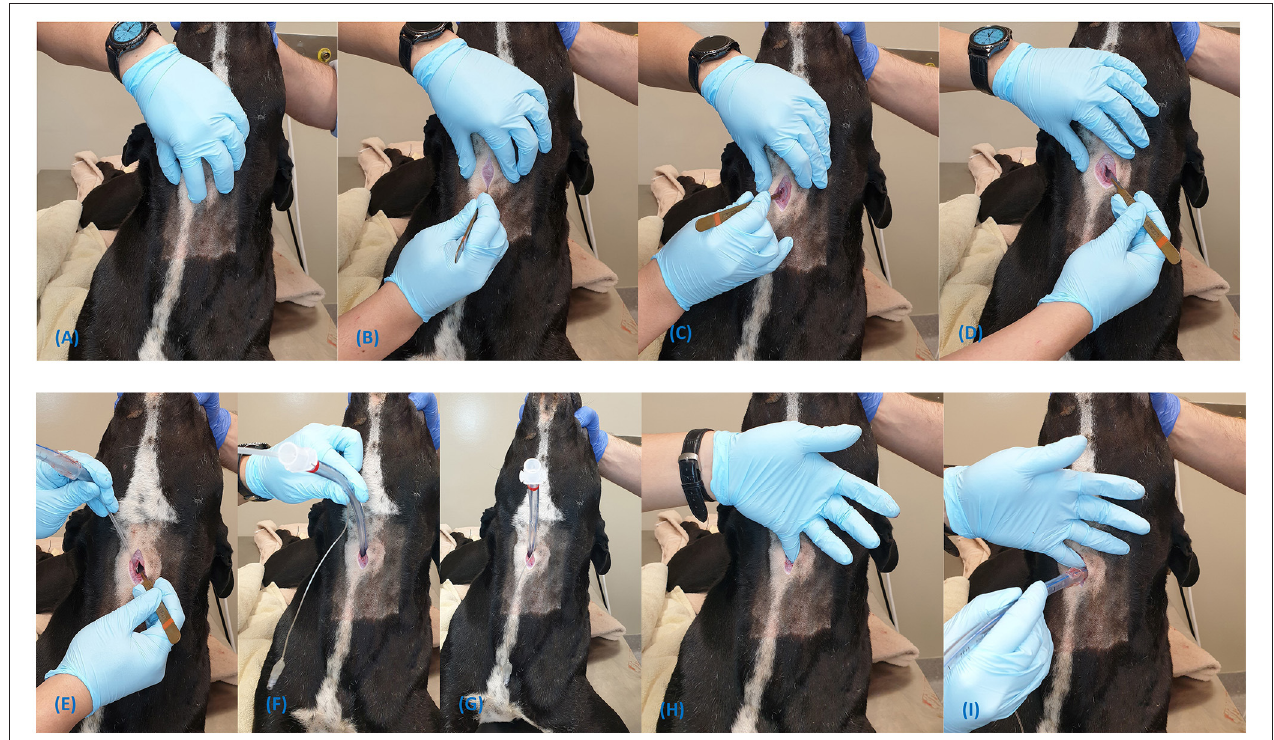
FIGURE 8 | Steps for the emergency awake cricothyrotomy (A–G) . The scalpel-finger-tube technique is demonstrated in (H,I) .